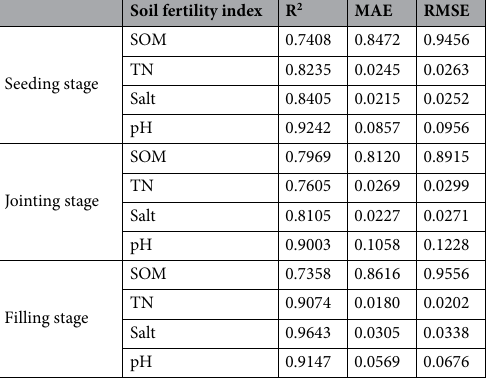
Table 9. The comparison between the measured values of 0 to 40 cm soil indexes in each treatment obtained by the experiment in 2020 and the simulated values obtained by PNN under the same